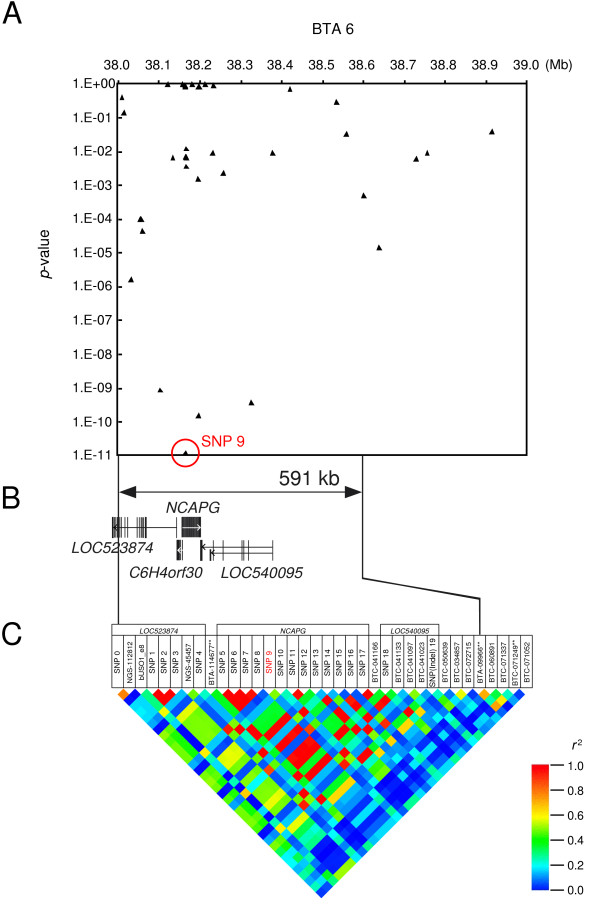
Association study in the IBS region using a Japanese Black population. (A) Association of the SNPs with carcass weight. A hundred and eighty-seven steers selected from the 4.7% extremes of 7990 steers were genotyped. P-values were calculated by Fisher's exact test for independence. (B) Genes located in the 591-kb region. (C) LD map. The LD was calculated for the 187 steers.